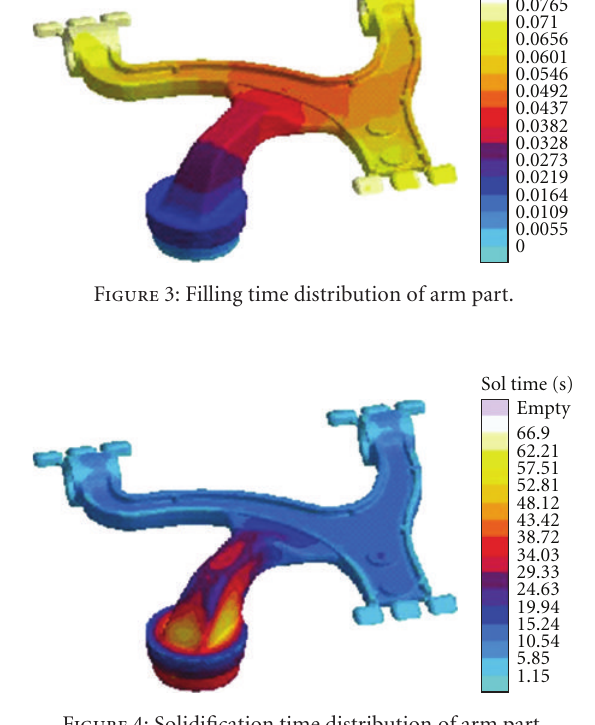
between the properties of A356 alloys. This includes primary α